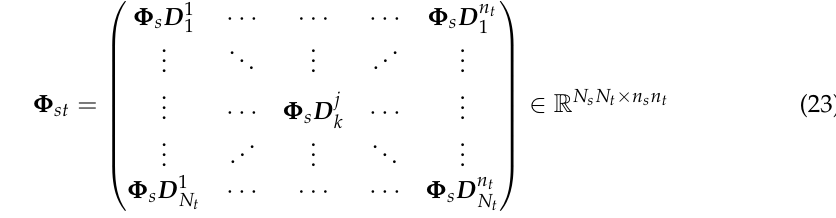
, µ , and µ . Each temporal behavior is denoted as v 1 1 2 3